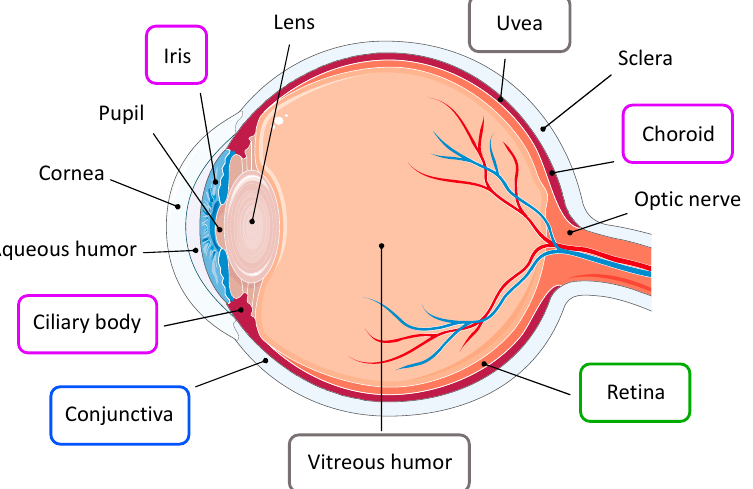
Figure 1. Tumors of the eye. Ophthalmic tumors affect specific ocular structures. Retinoblastoma (green) arises in the retina; conjunctival melanoma (blue) involves the conjunctival epithelium; uveal melanoma (purple) develops from any region of the uveal tract; ocular lymphomas (grey) derive from the vitreoretinal tissue or from the uvea.